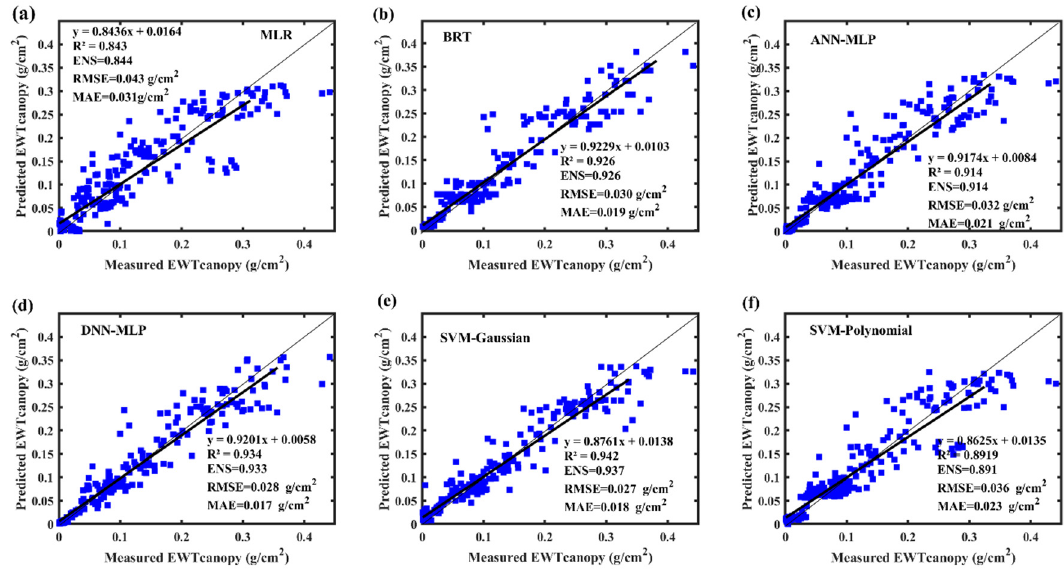
Figure 7. Scatter plots of predicted EWT canopy according to multiple linear regression (MLR, a ), boosted regression tree (BRT, b ), artificial neural network (ANN, c ), deep neural network (DNN, d ), support vector machine Gaussian (SVM-Gaussian, e ) and support vector machine polynomial (SVM-Polynomial, f ) models versus the EWT canopy values measured from all datasets. Table 6. Summary statistics of multiple linear regression models.